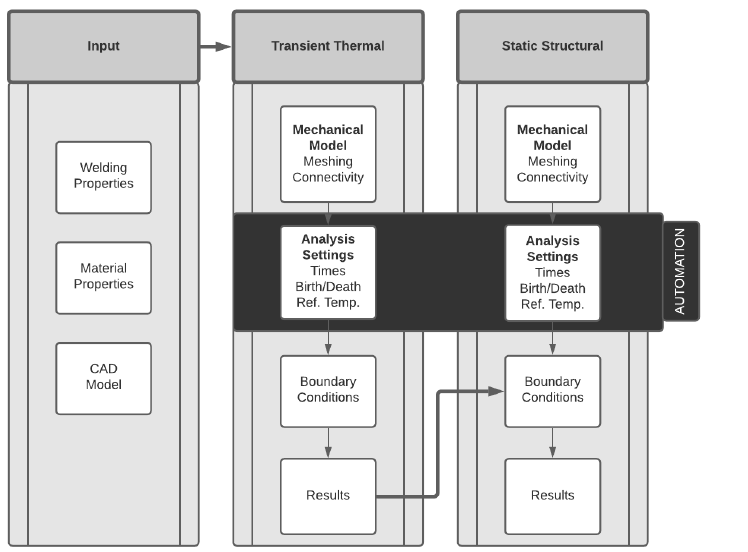
Figure 1. Proposed methodology